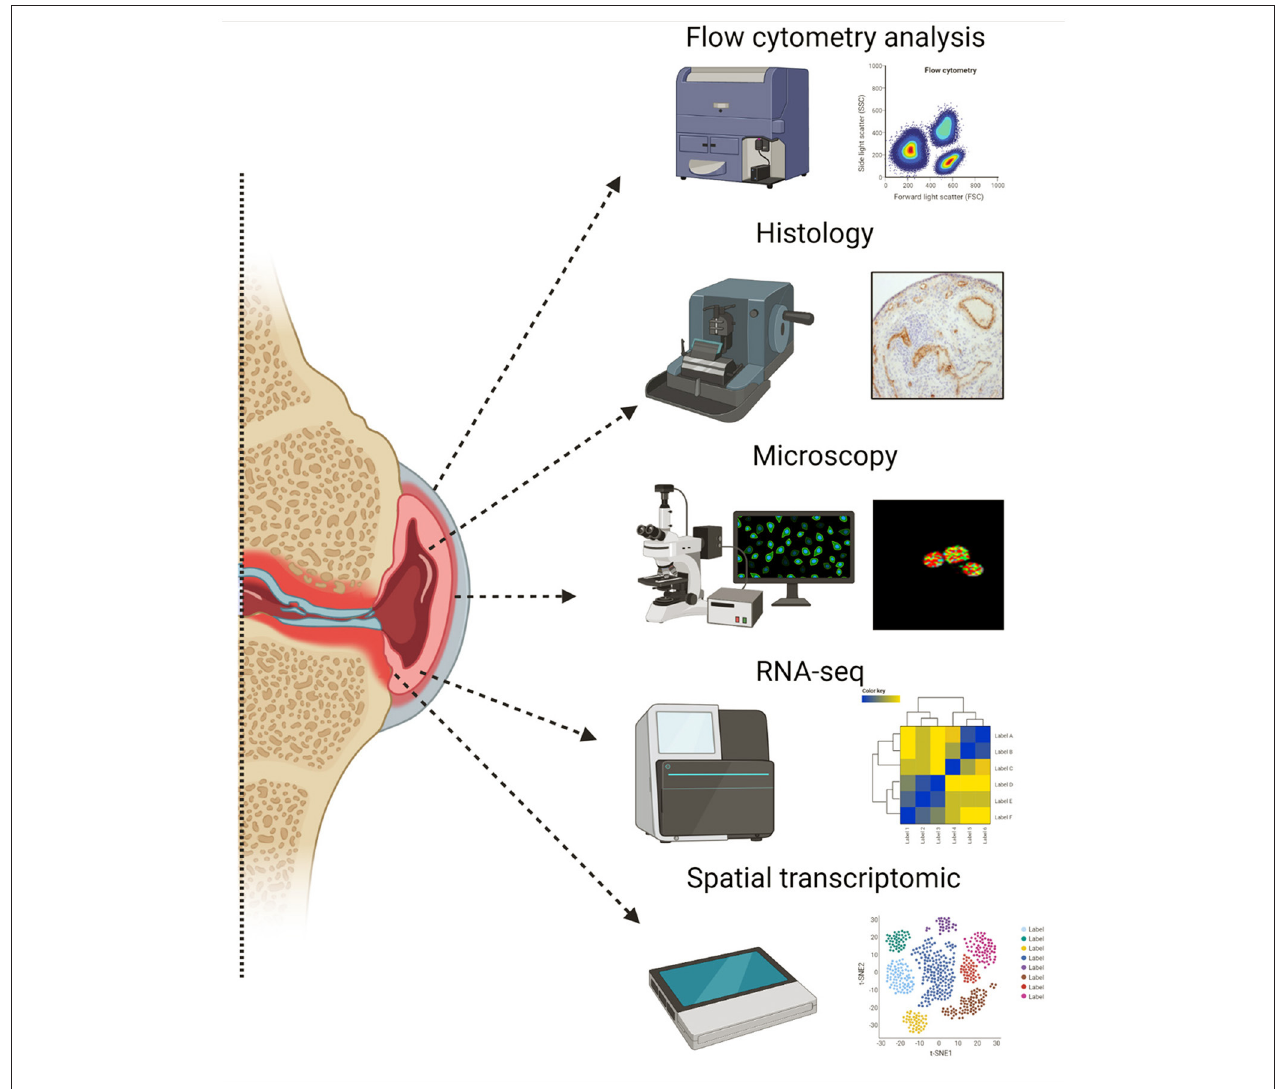
FIGURE 5 | Illustration of key techniques used in synovial tissue research. Created with